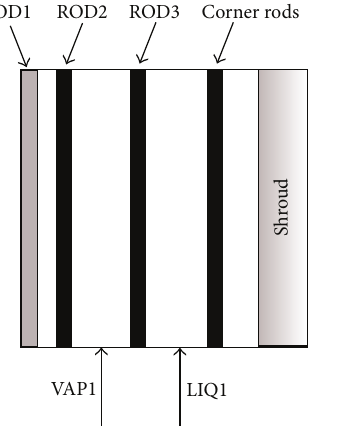
Figure 18: QUENCH-06 test calculation using ASTEC code. Fuel rod imitator cladding temperature in outer ring of bundle at 750 mm height.